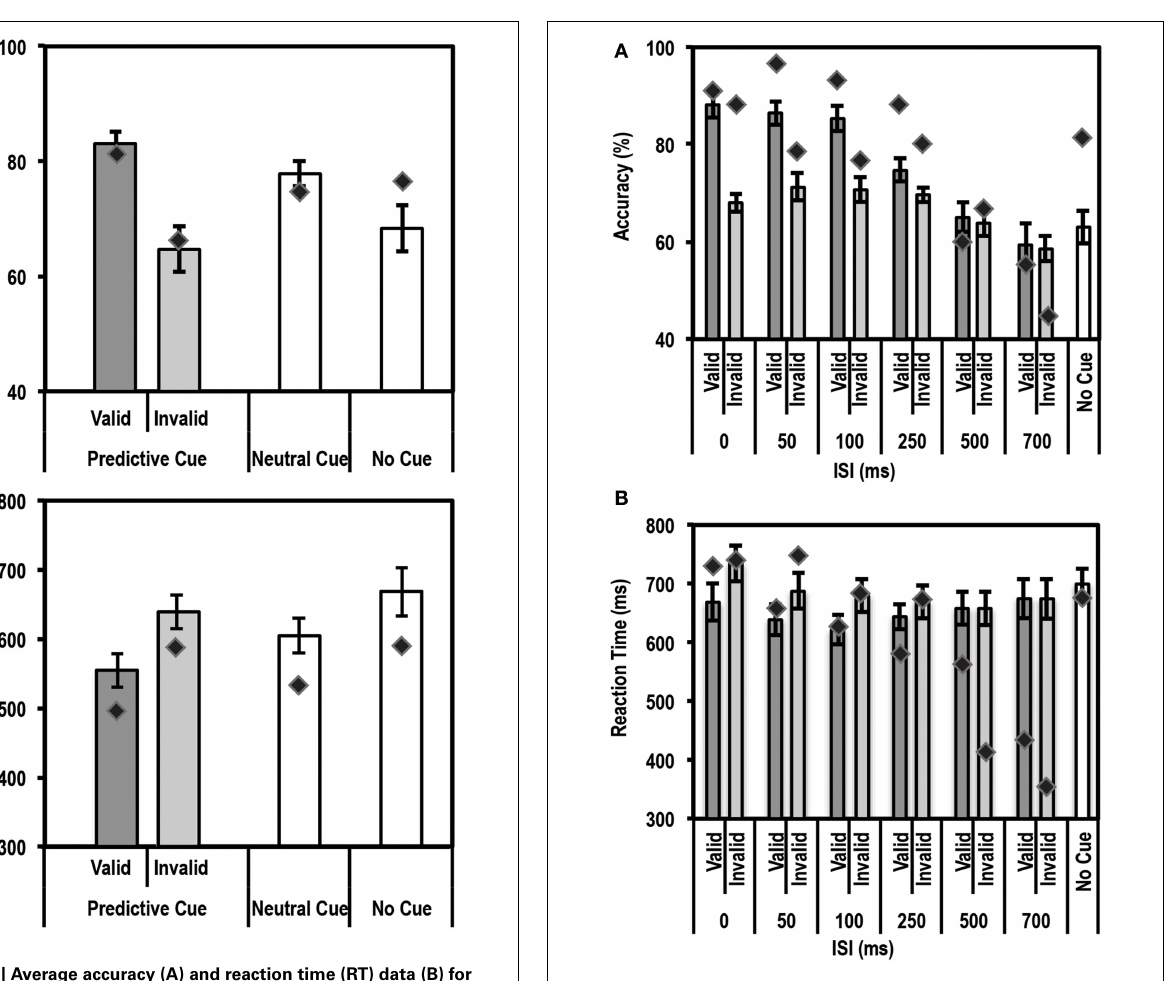
14.7% ± 7.0; t (9) = 6 . 6; p = 0 . 000049]. The accuracy